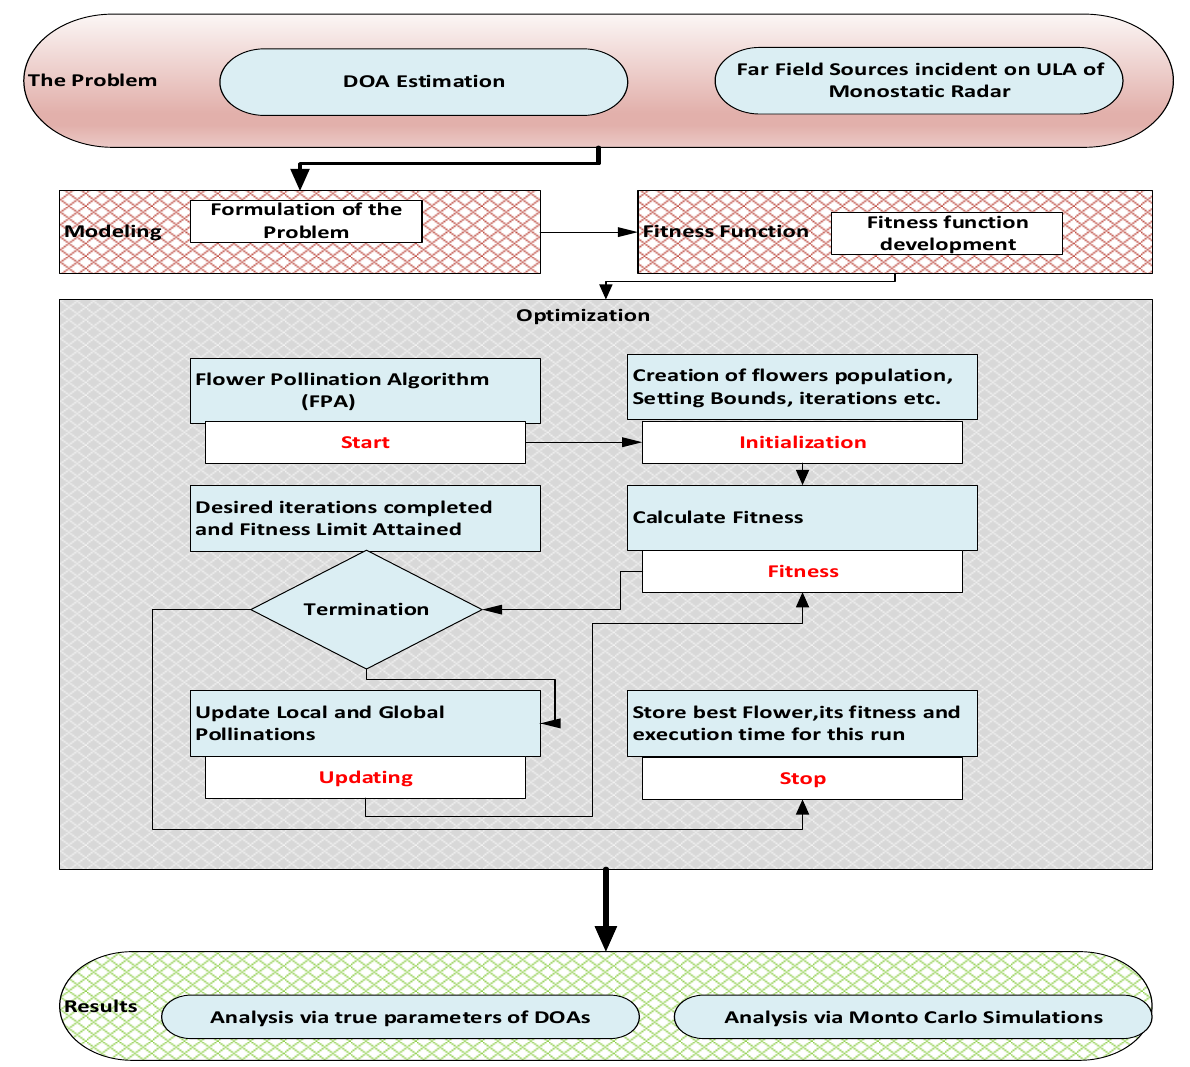
Figure 3. Overall Graphical Abstract.